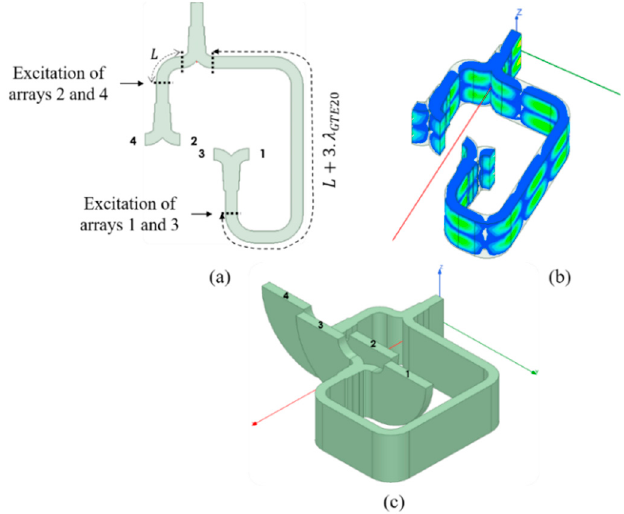
Figure 10. Design of the feeding network. ( a ) Top view. ( b ) 3D plot of the electrical field. ( c ) 3D view with coupling bends 1,2,3,4.